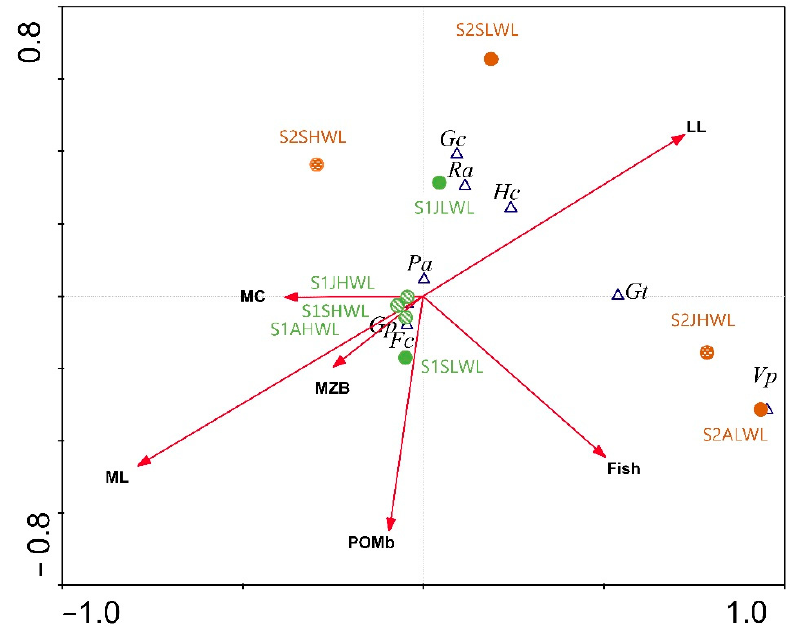
Figure 8. CCA-plot indicating relationships among sampling sites, physicochemical variables, and abundance of common gastropod species in the littoral benthal areas of S1 and S2. Abbreviations are provided in Materials and Methods.